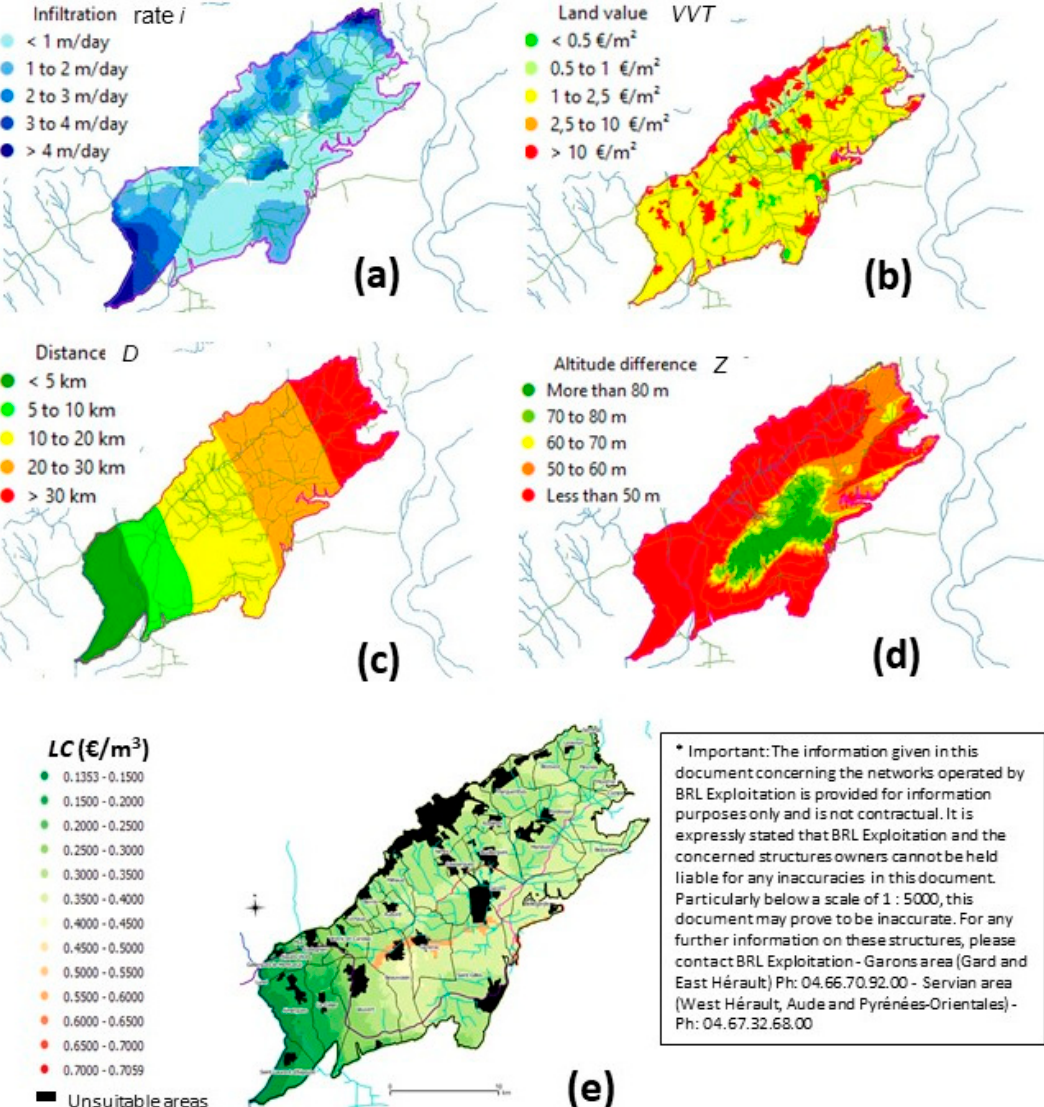
Figure 5. VCP case study: ( a ) map of soil infiltration rates i (m/day), ( b ) land market value LMV (€/m 2 ), ( c ) distance to one river D (Vidourle in this case), ( d ) elevation difference Z with closest river/stream, ( e ) minimum levelised cost LC map (in black: areas identified as unfavourable to infiltration basins due to land use constraints, most of the time corresponding to urban areas).